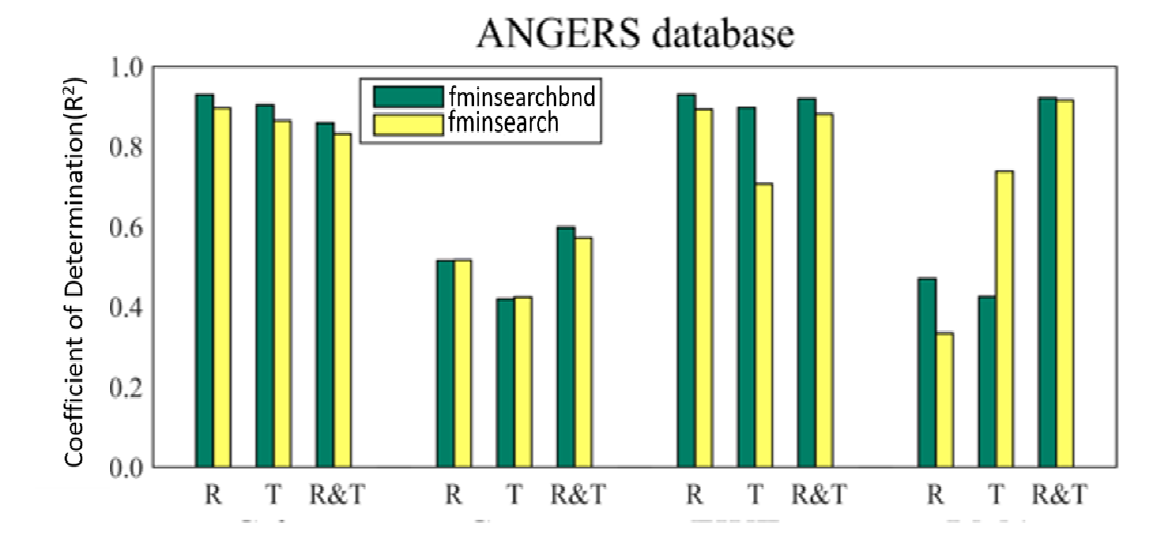
Figure 1 . Values of coefficient of determination (R 2 ) using the N-M method to invert biochemical parameters based on the spectra of reflectance (R), transmittance (T) and both (R&T). The data are from ANGERS